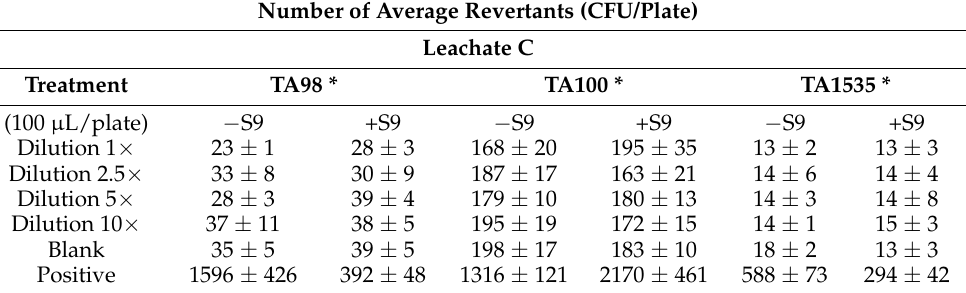
Table 7. Revertant frequency of Salmonella tester strains TA98, TA100, and TA1535 following incubation with leachate C from PFA in presence and absence of S9 mix (mean ± SD is